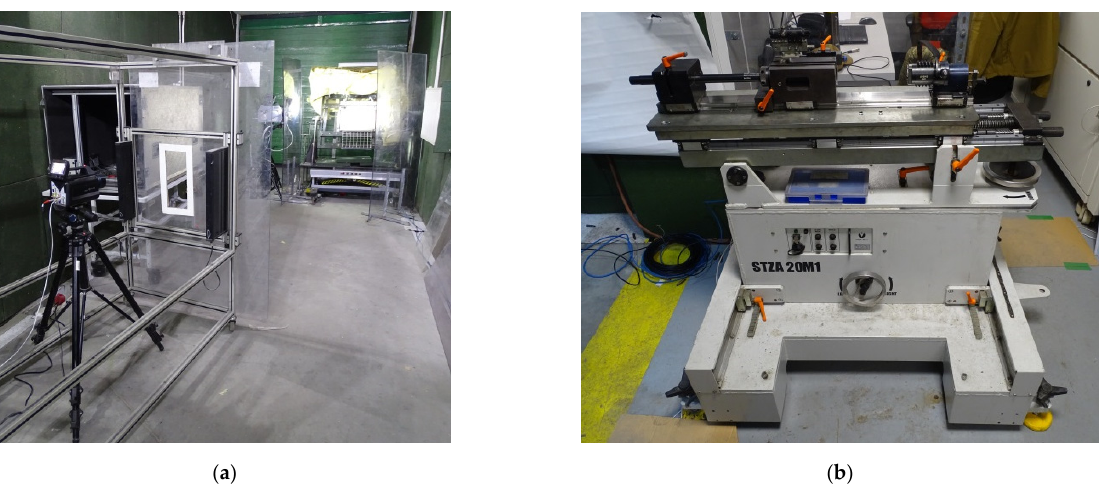
Figure 2. Stand for the temperature testing of ricochetting projectiles: ( a ) FLIR X6580sc thermal camera; ( b ) tripod with a 7.62 × 51 mm ballistic barrel.